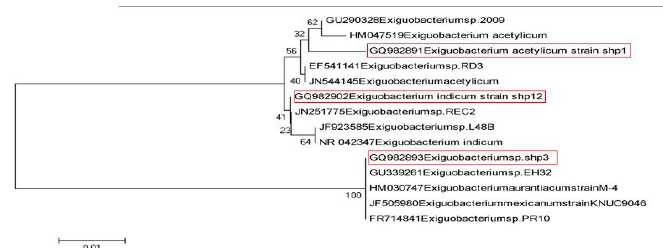
Fig. 5. Phylogenetic analysis of WSM-2, RRFM-1 and